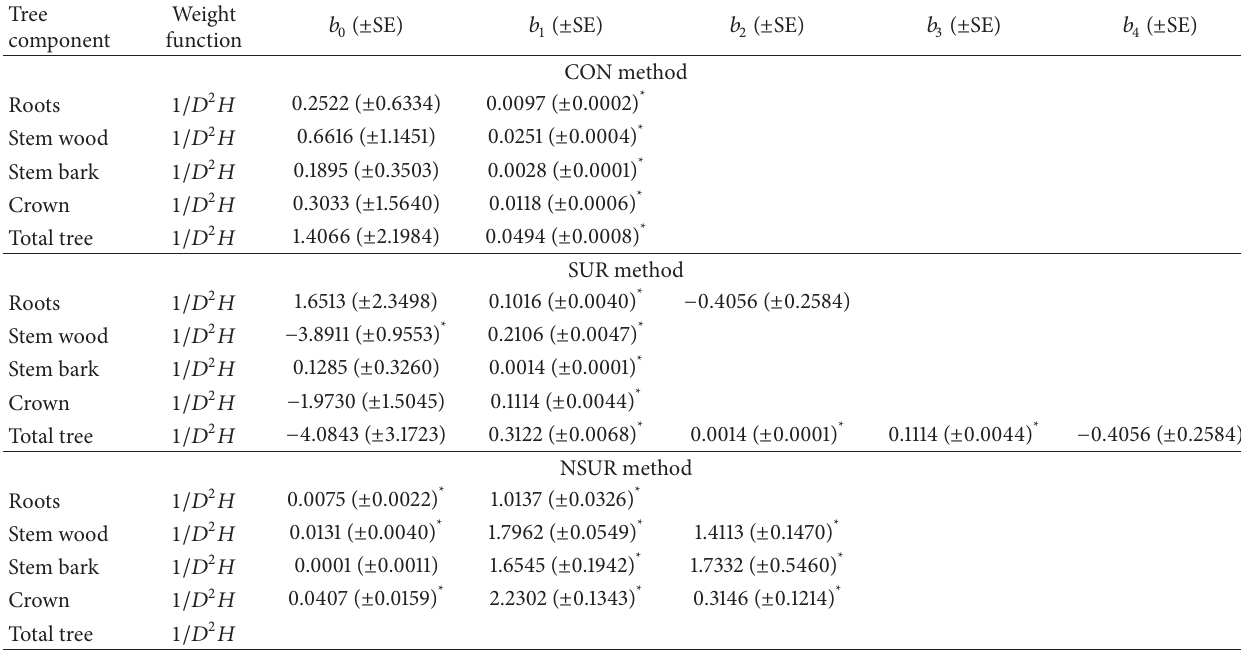
Table 6: Coefficients of regression for CON, SUR, and NSUR methods.